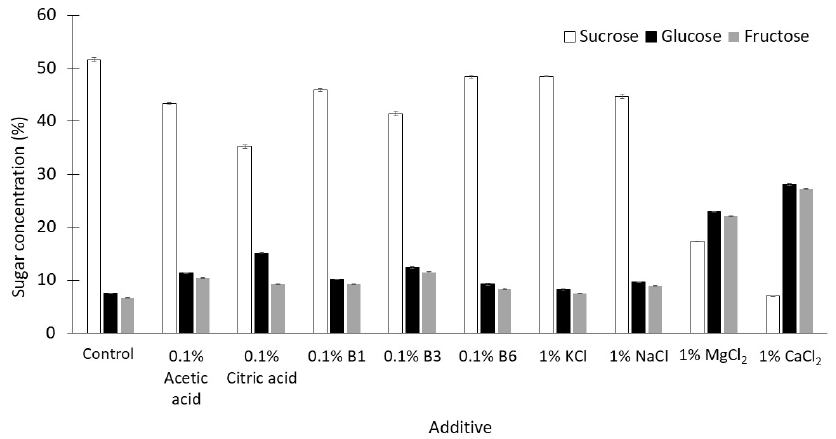
Figure 3. Concentrations of sugars (mean ± SD, n = 3) in syrups prepared from thick juices containing single additives by heating at 120 °C for 30 min.